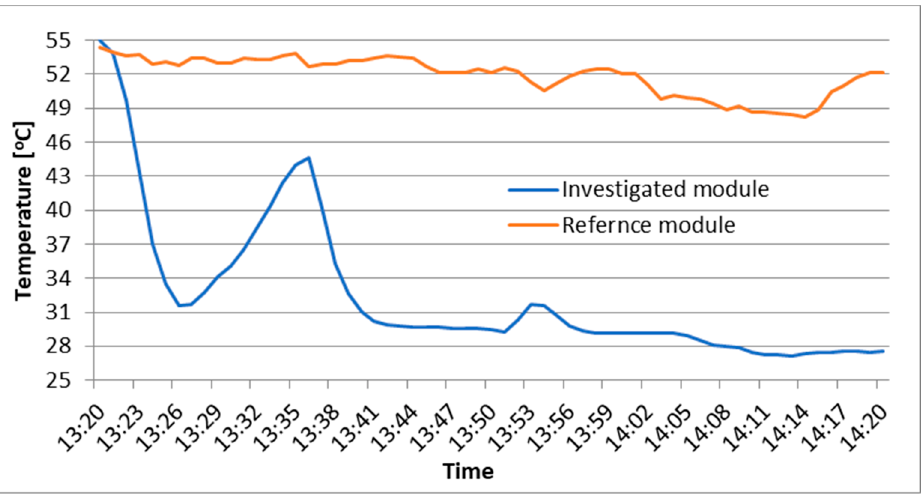
Figure 12. Temperatures of investigated and reference modules during the maximal power test.